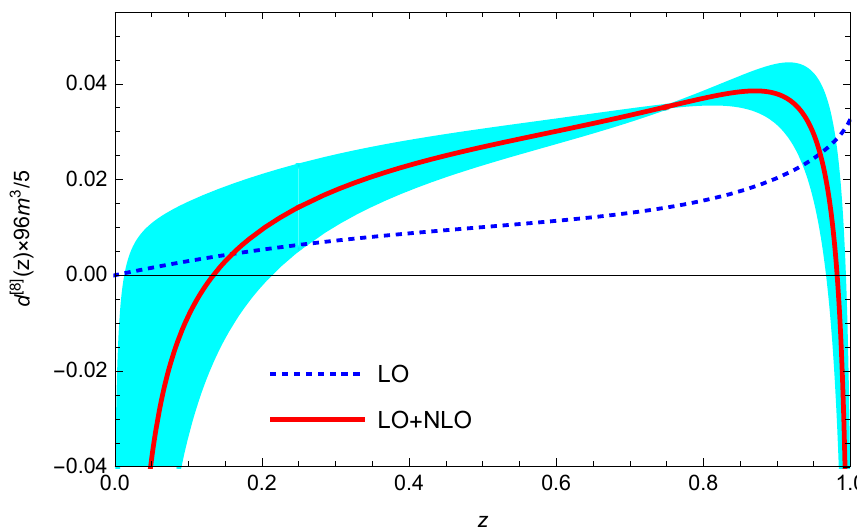
) + X at LO and NLO. The dotted 0 (cid:1) (cid:0) d [8] ( z ) + d [8] ( z ) (cid:2) (96 m 3 = 5), with scale b LO NLO